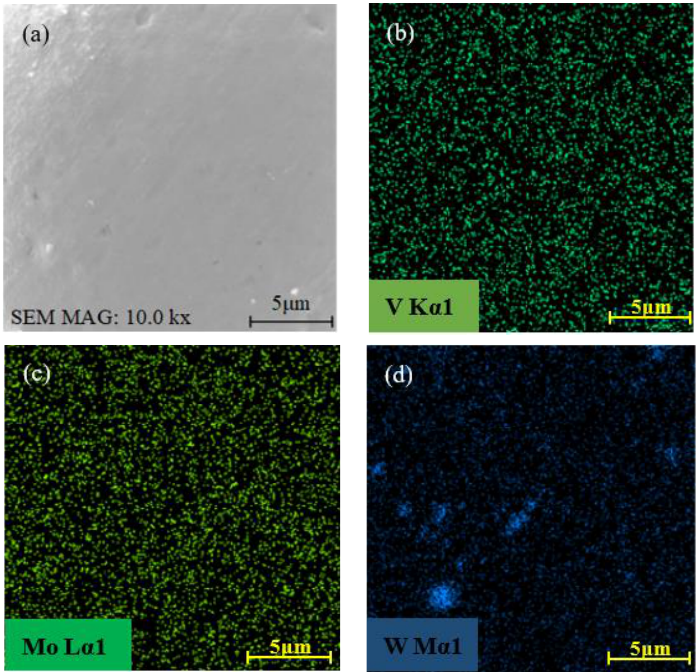
Figure 6. Morphology of the V 1.6 Mo 1.7 W 1.8 /TiO 2 after reaction. ( a ) SEM image, 10.0 kx; ( b ) EDS image V element dispersion; ( c ) EDS image Mo element dispersion; ( d ) EDS image W element dispersion.